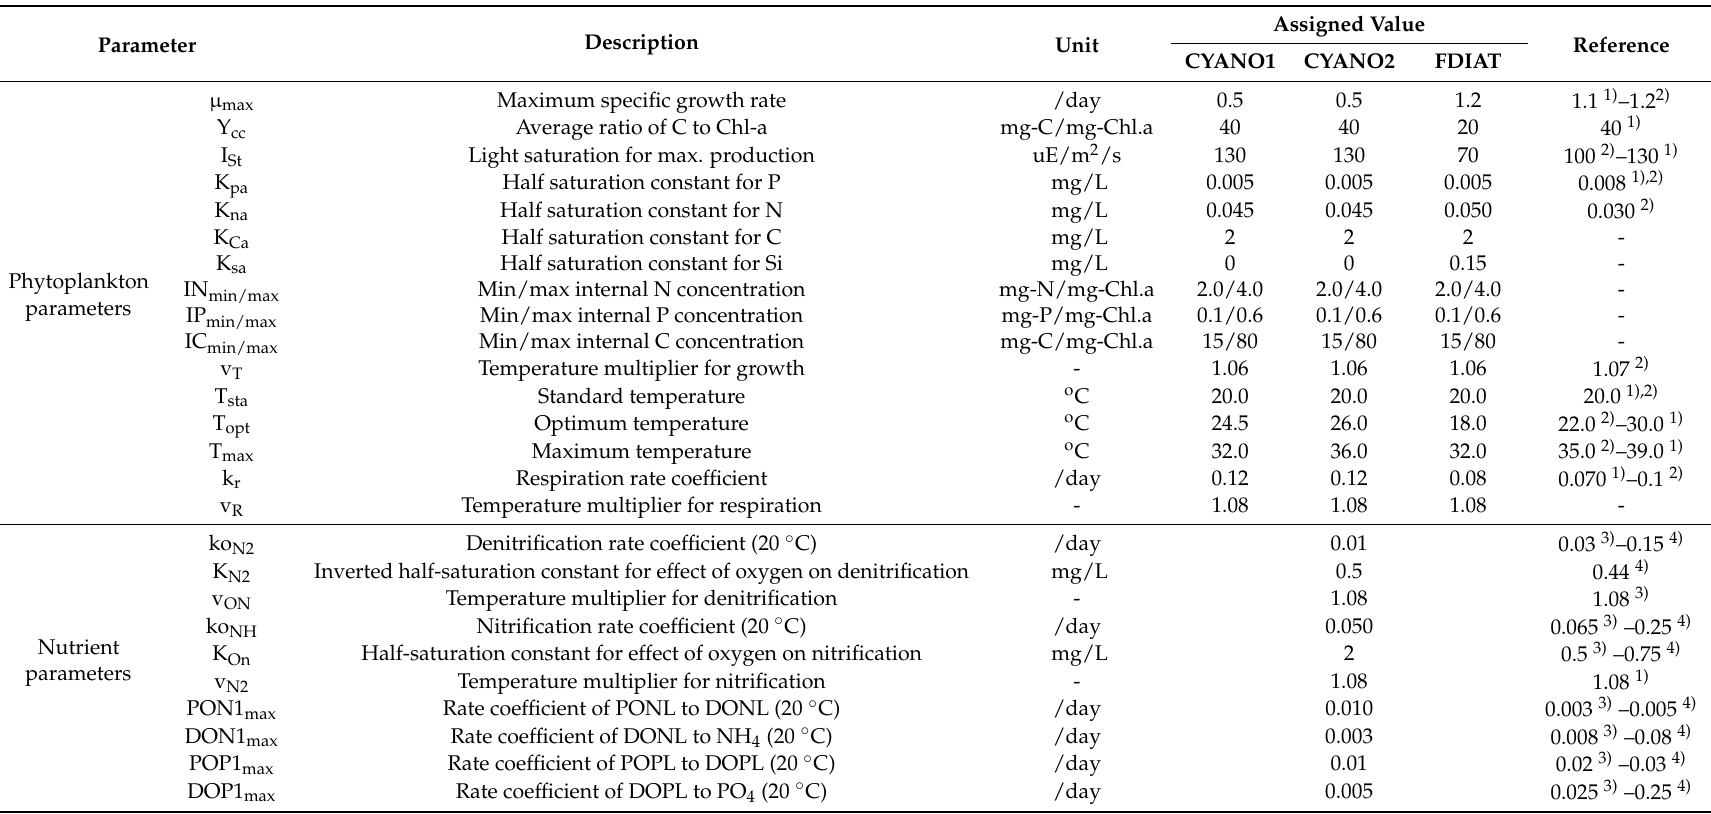
Table 3. Water quality parameters applied in the computational aquatic ecosystem dynamic model (CAEDYM) for the Jinyang